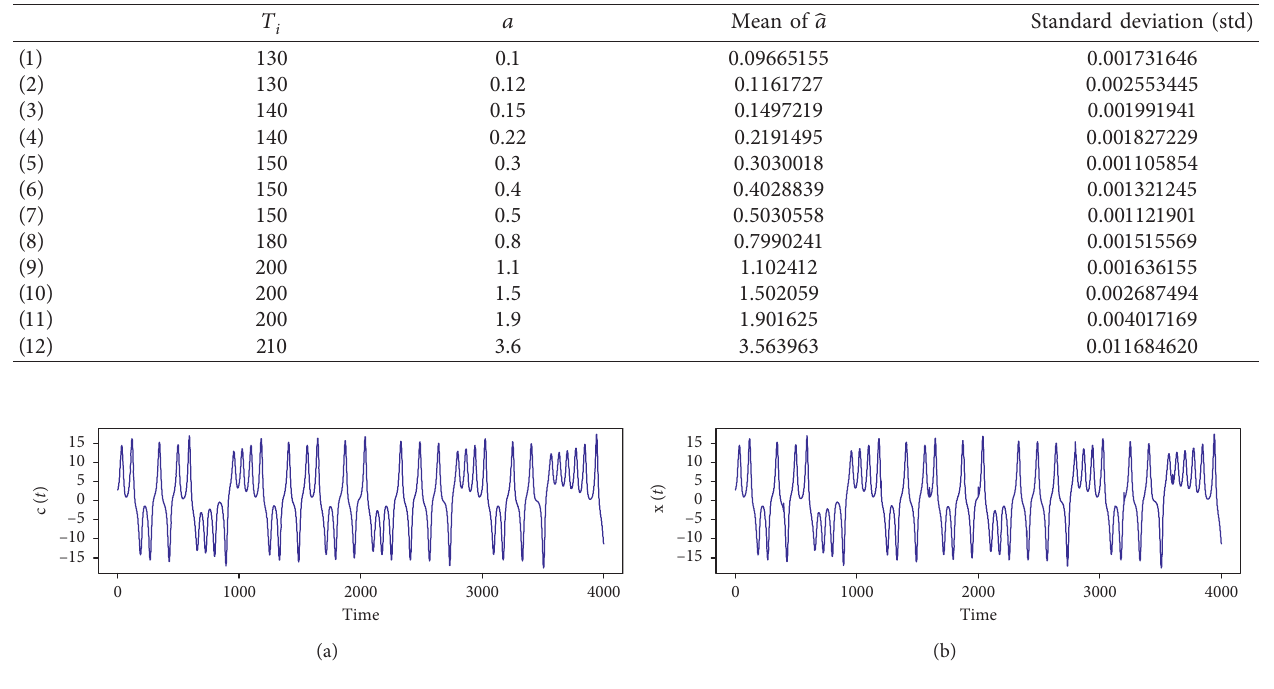
Table 2: Predicted value of a and standard deviation with different SNRs.